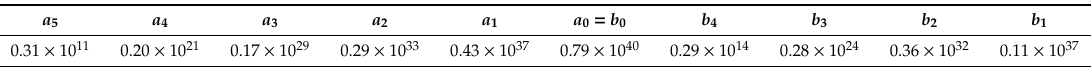
Table A1. Numerical values of the coefficients of the differential equation for a looped system.